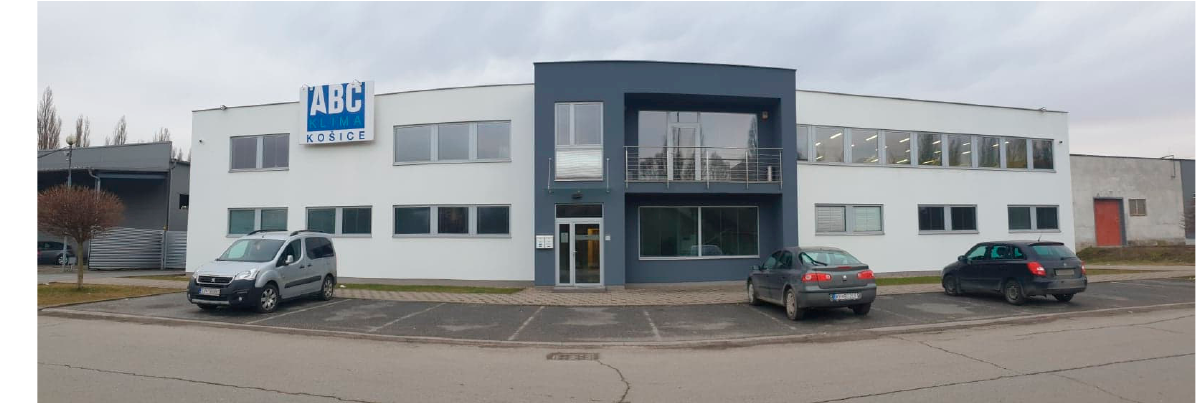
Figure 2. Front view of the building.